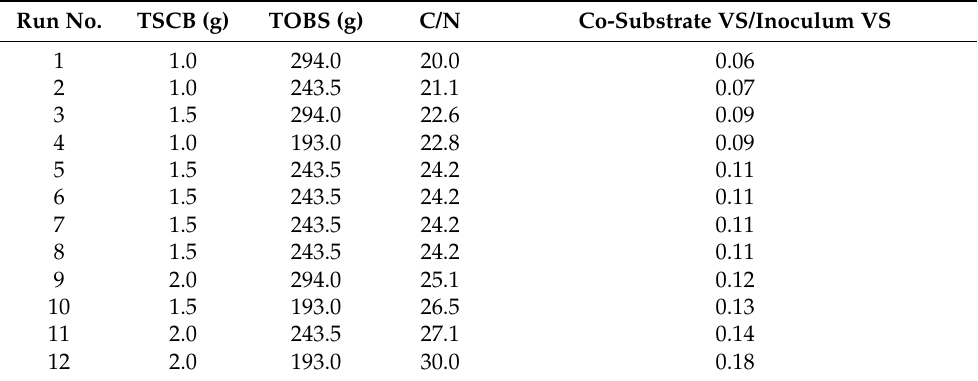
Table 5. Quantities of TOBS and TSCB added to obtain carbon/nitrogen (C/N) ratios between 20 and